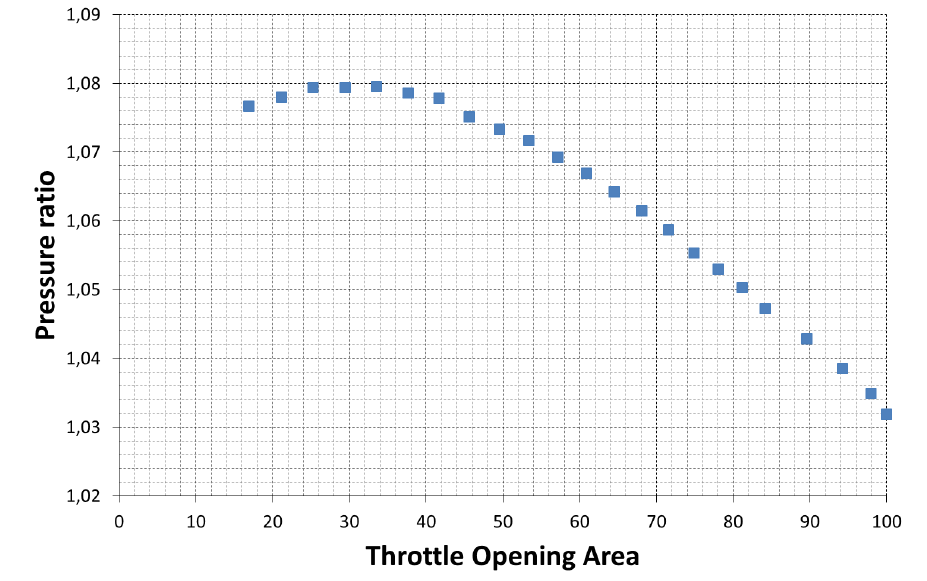
Figure 3: Blower performance curve relative to the TOA parameter